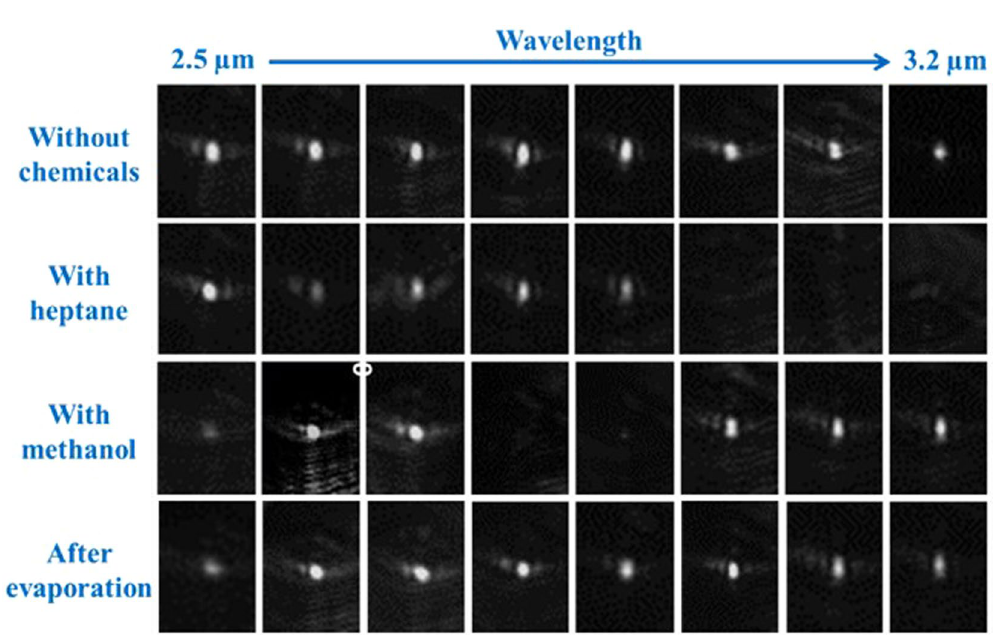
Figure 3. The waveguide mode images were captured from λ = 2.5 µ m to 3.2 µ m with or without chemicals covering the waveguide. Fundamental modes were clearly observed over a broad spectral range. When heptane was presented, the mode disappeared at λ = 3.0 µ m–3.2 µ m corresponding to -CH absorption. For methanol, the mode vanished at λ = 2.8 µ m–2.9 µ m associating with -OH absorption. The mode intensities recovered when the analytes evaporated from the waveguide